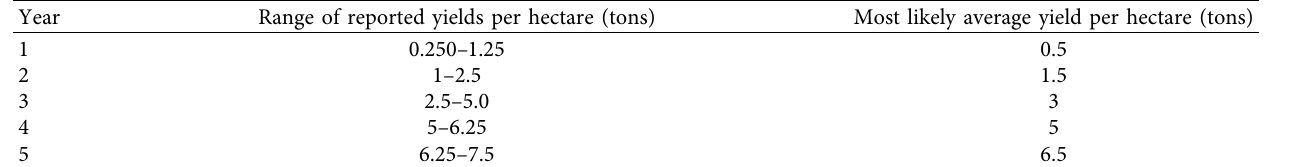
Figure 2: Flow chart of Moringa oleifera cultivation methods [34]. Table 2: Range of Moringa oleifera yield per hectare [7, 35,